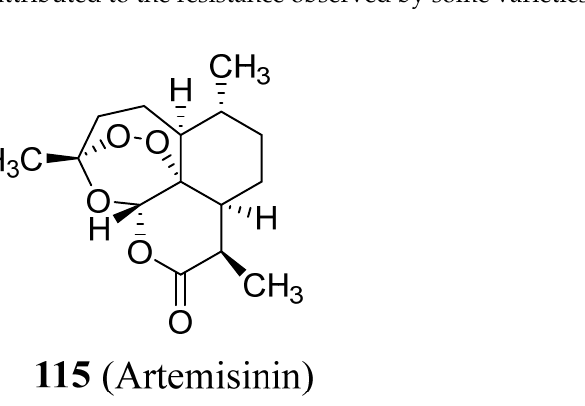
Figure 9. Artemisinin, antimalarial drug.